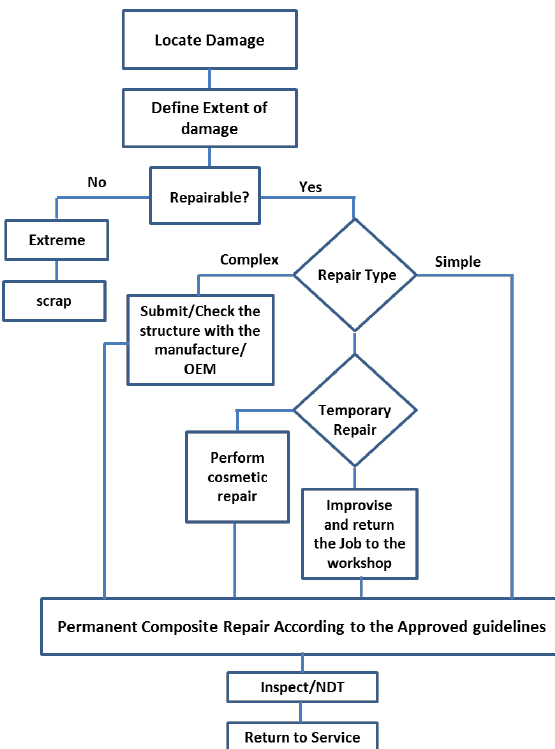
Figure 2. Key stages of composite repair. The concept has been redesign on the basis of ref. [46].